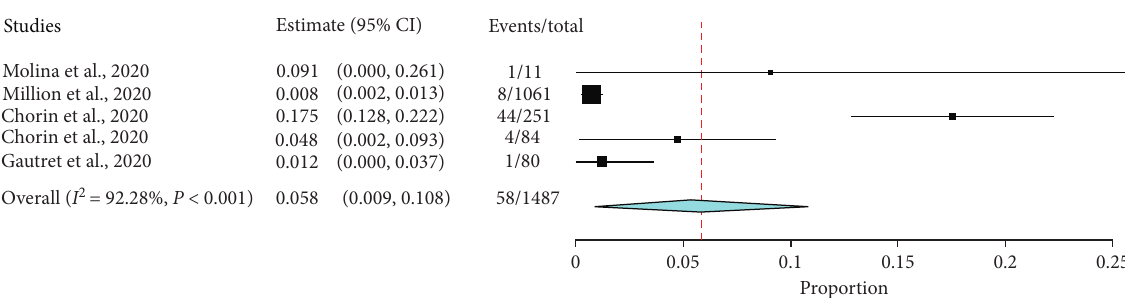
Figure 4: The pooled prevalence of mortality among COVD-19 patients treated with HCQ with or without